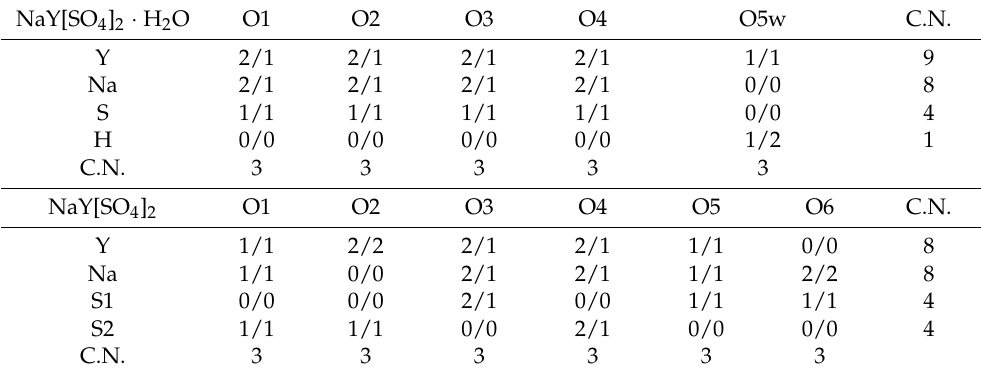
Table 5. Motifs of mutual adjunction for NaY[SO 4 ] 2 · H 2 O (top) and NaY[SO 4 ] 2